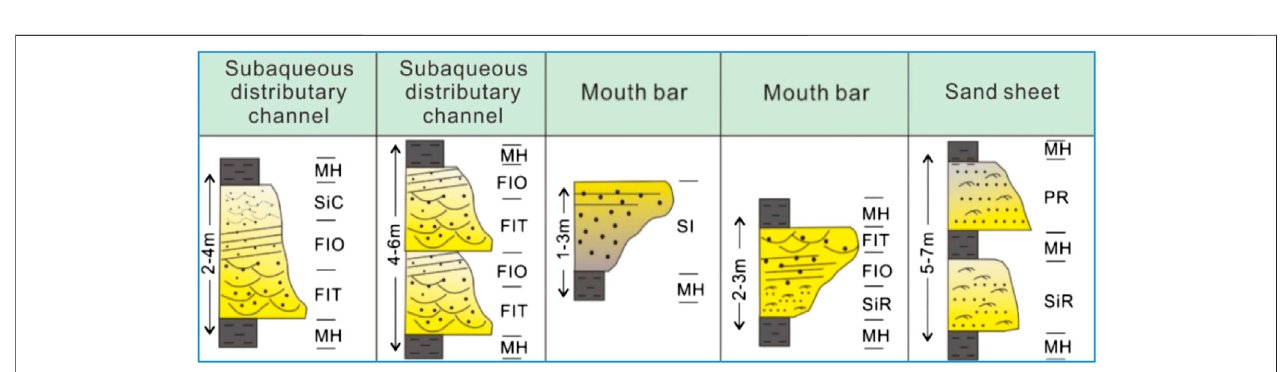
FIGURE 7 | Five combined lithofacies types of delta front facies in the study area (different single lithofacies are superimposed vertically according to certain rules).